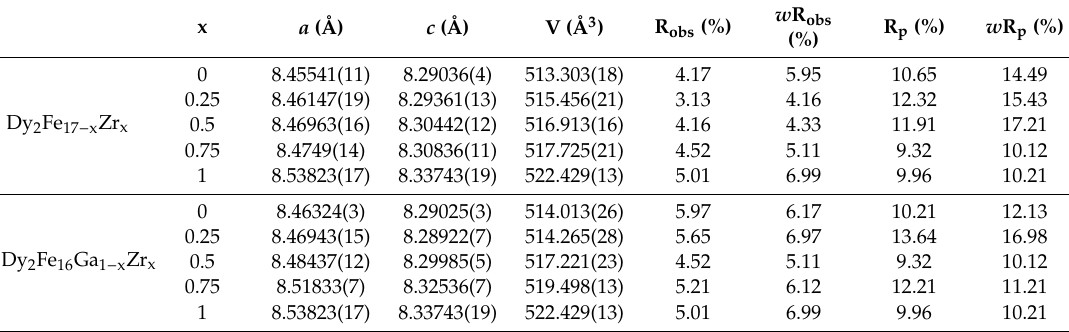
Figure 2. Lattice parameters a and c and unit cell volume of ( a ) Dy 2 Fe 17 − x Zr x and ( b ) Dy 2 Fe 16 Ga 1 − x Zr x as a function of Zr content.